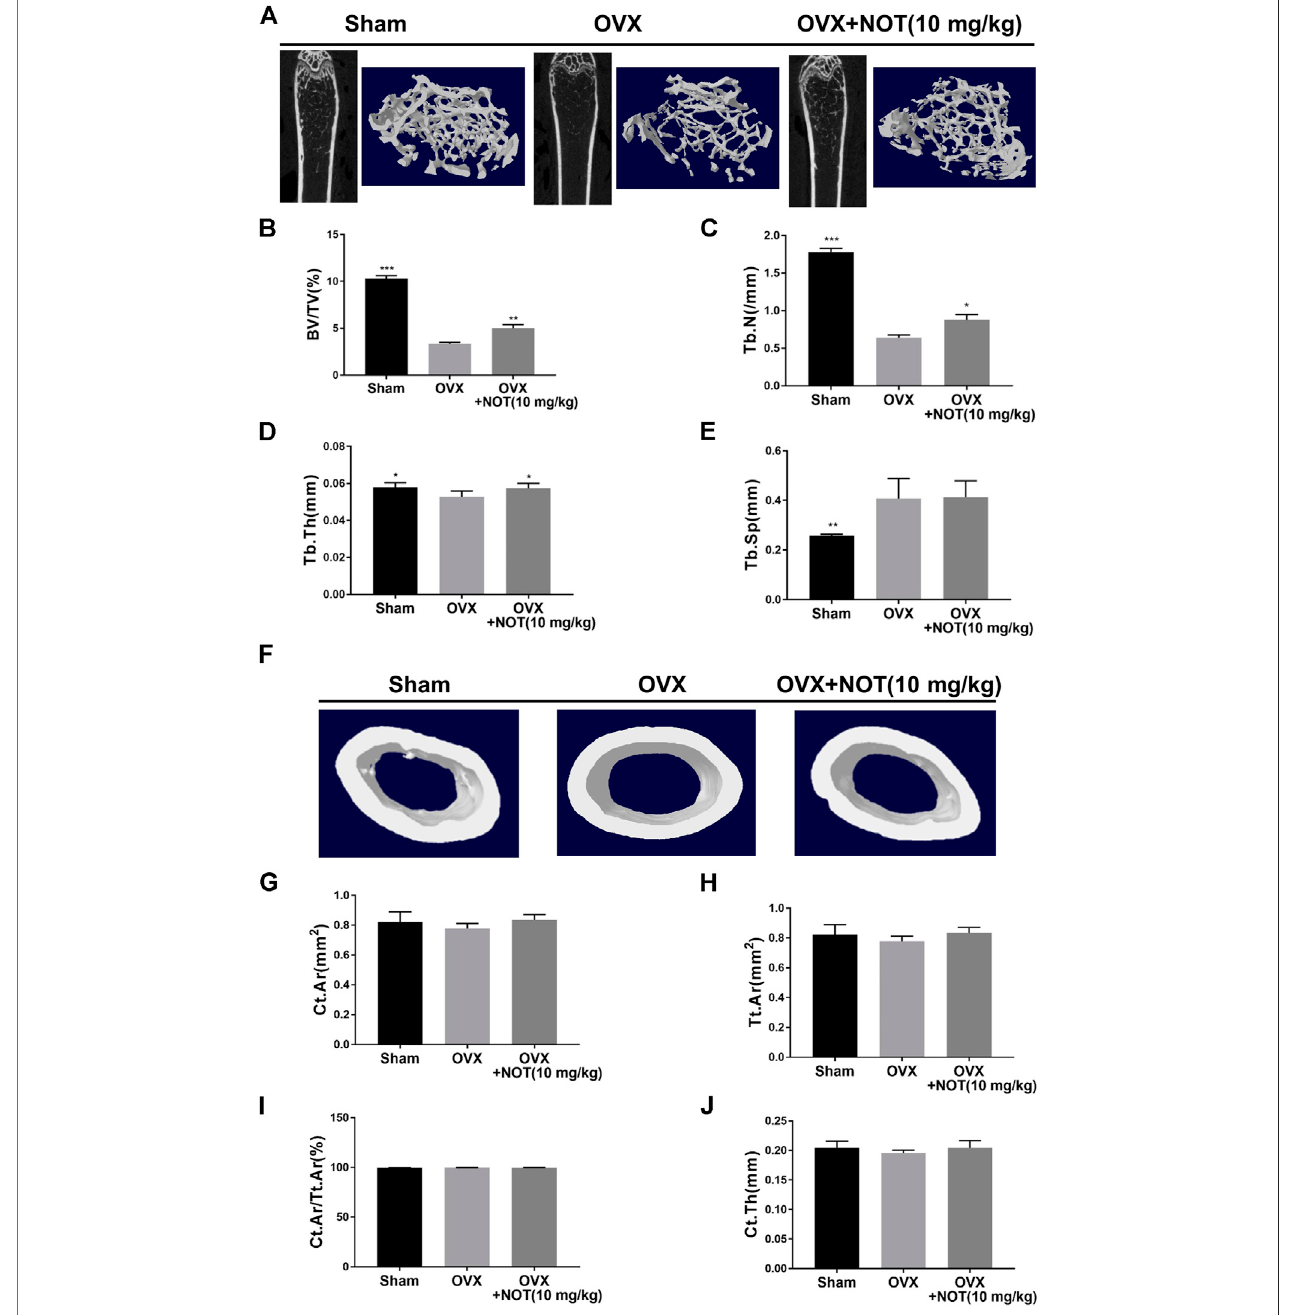
FIGURE 6 | Notopterol treatment prevents bone loss in OVX-induced mice in vivo . (A) Representative 2-dimensional and 3-dimensional reconstruction micro-CT images of trabecular bone microarchitecture in the different groups. Trabecular bone was analyzed by micro-CT in sham-operated, ovariectomized mice after vehicle or Notopteroltreatment(10 μ M). (B – E) Trabecularbonevolume/tissuevolumefraction (B) ,trabecularnumber (C) ,trabecularthickness (D) weredramaticallyup-regulatedafter exposure to Notopterol. Trabecular separation has no obvious difference among these groups (E) . (F) Representative 3-dimensional reconstructed region of cortical bonesuggestednodifferenceamongthreegroupsinthefemur.Corticalbonearea (G) ,totaltissuearea (H) ,corticalareafraction (I) aswellascorticalthickness (J) werealso lessdifferentintheabsentorpresentNotopterolgroups.Dataarepresentedasmean ± SEM. n (cid:2) 5pergroup.* p < 0.05,** p < 0.01and*** p < 0.001relativetotheOVXgroup.